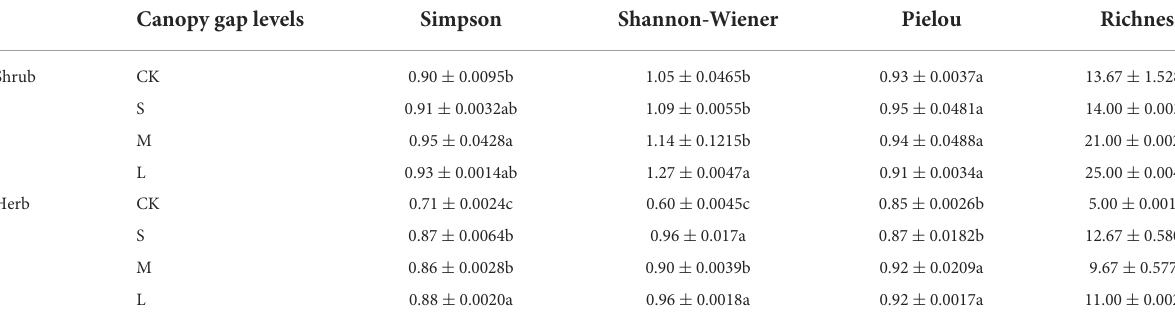
TABLE 1 Understory plant diversity indices of herbs and shrubs at different canopy gap levels. Canopy gap levels Simpson Shannon-Wiener Pielou